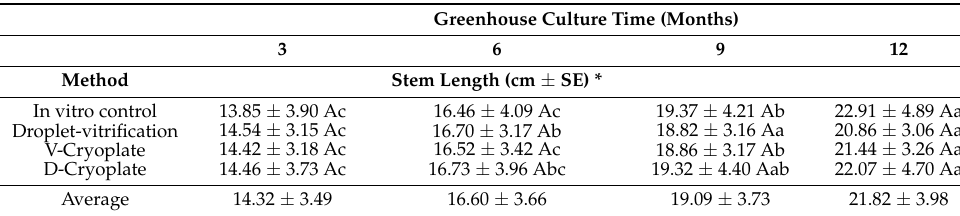
Table 2. Comparison of stem length between in vitro controls and cryo-derived plants of Vanilla planifolia during greenhouse culture.